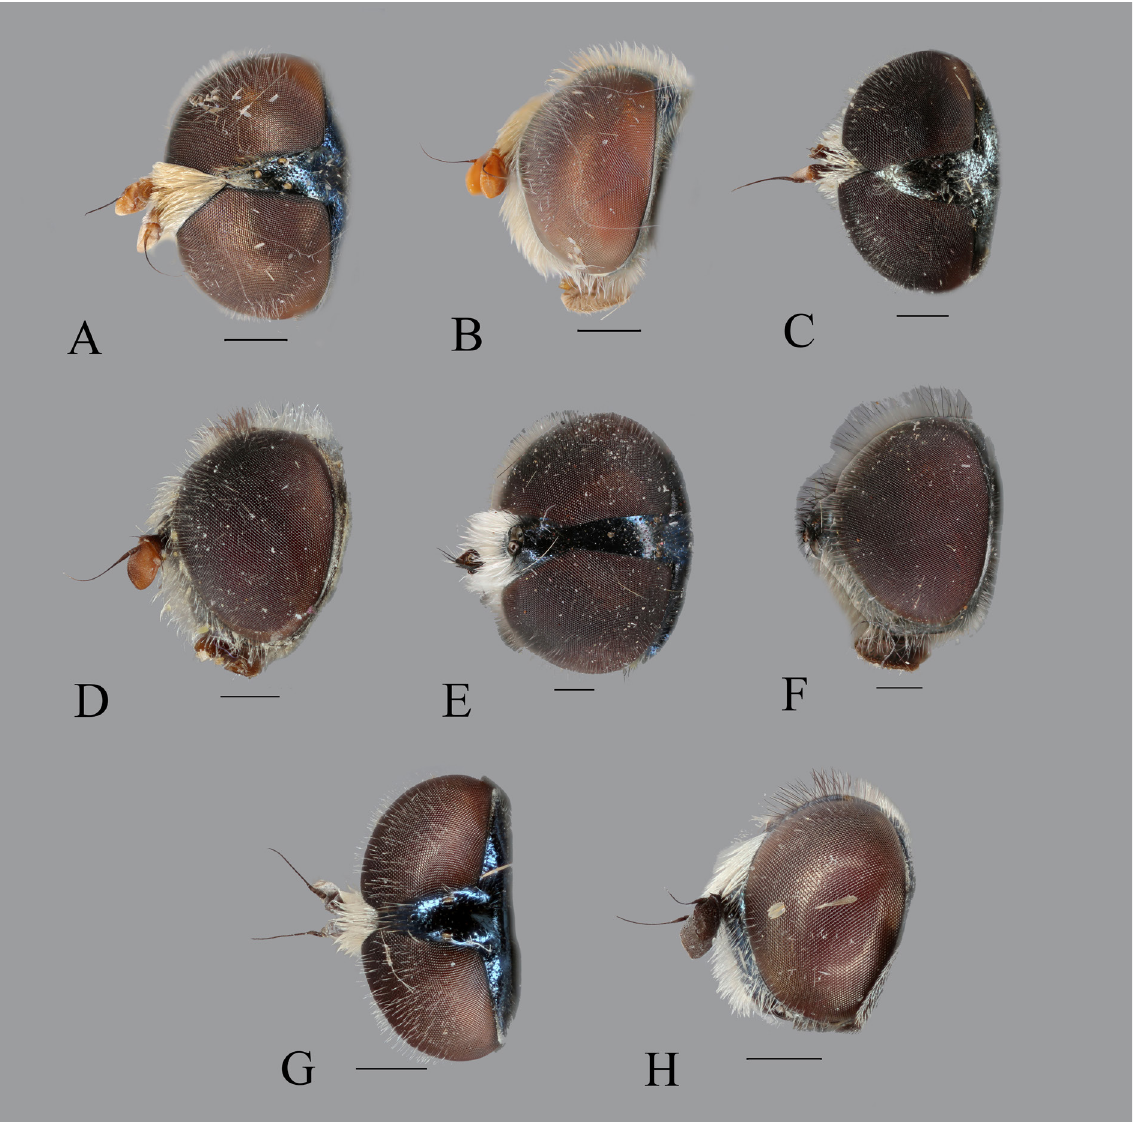
Fig. 17. Head, ♂, dorsal view (A, C, E, G) and lateral view (B, D, F, H). A–B . Eumerus pilosipedes Gilasian & van Steenis sp. nov., holotype (HMIM). C–D . E. richteri Stackelberg, 1960, Lar, Iran (HMIM). E–F . E. tadzhikorum Stackelberg, 1949, Chekab Valley, Iran (JSA). G–H . E. vallicolous Gilasian & van Steenis sp. nov., holotype (HMIM). Scale bars = 0.5